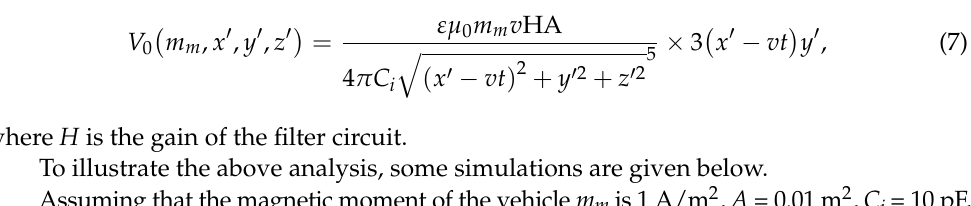
Figure 3. Process of moving target detection.